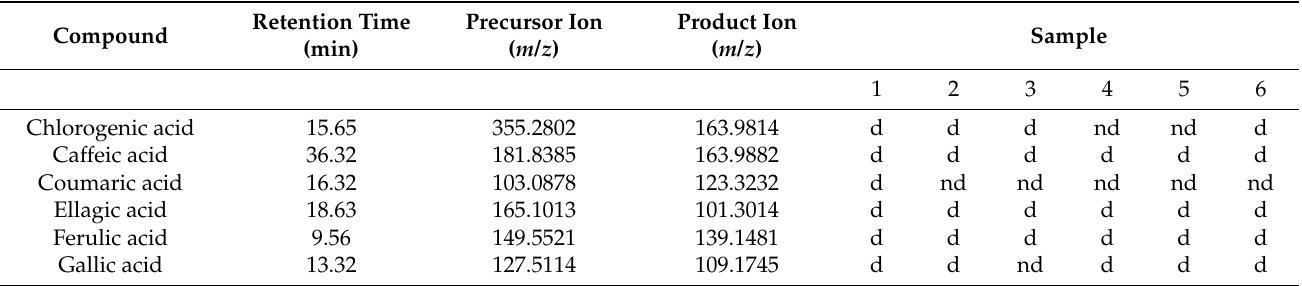
Table 3. Phenolic acids detected in extracts of defatted Willamette, Polka, and Meeker raspberry seeds, obtained using UAE under optimal conditions and after hydrolysis.